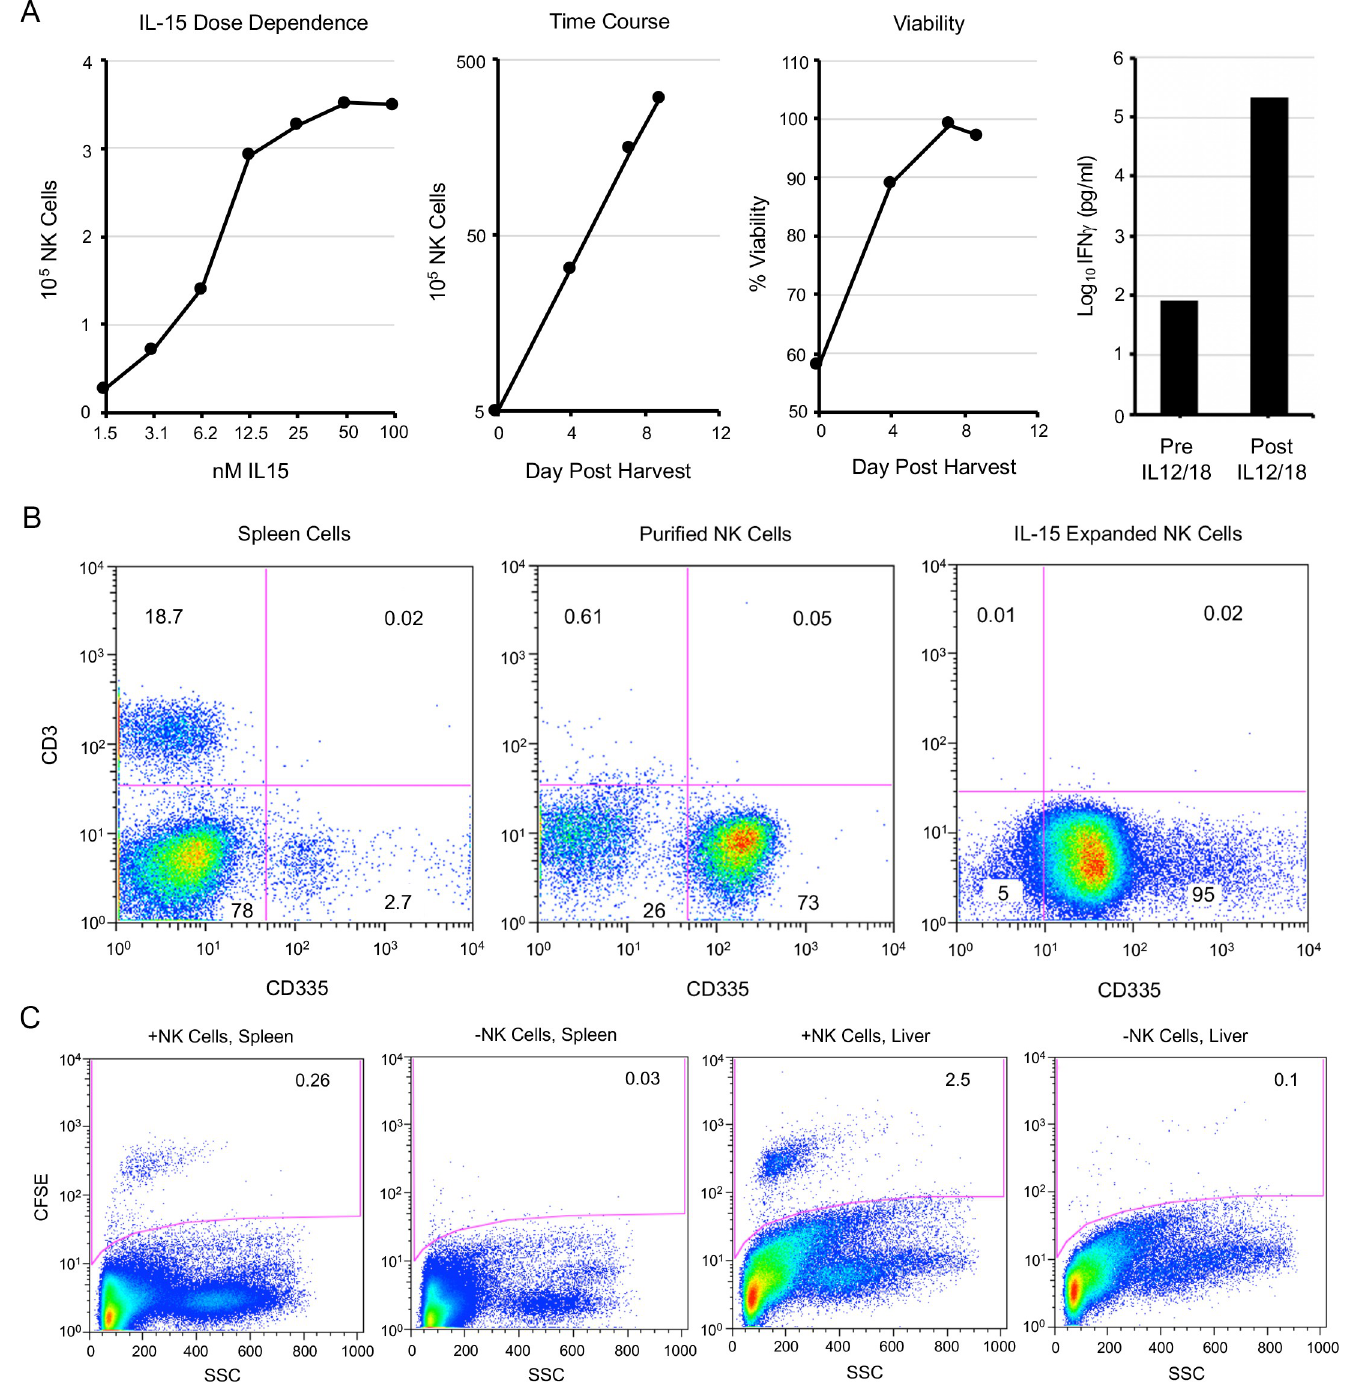
Fig 5. Purification and expansion of splenic NK cells. (A) Spleen cells from CAST mice were purified by negative selection. In left-most panel, 2-fold dilutions of IL- 15 were added to purified NK cells for 5 days at 37˚C and counted with a cellometer. Second panel from left shows expansion of NK cells incubated in 50 nM IL-15 over time. Third panel from left shows cell numbers and viability (trypan blue exclusion) determined with a cellometer in presence of 50 nM IL-15. Fourth panel from left shows the amounts of IFN- γ in the medium before and after incubation of expanded NK cells for 18 h with IL-12/IL-18. (B) Spleen cells before and after NK cell purification and following expansion with IL-15 were stained with anti-CD3 and anti-CD335 antibodies and analyzed by flow cytometry as described in the legend to Fig 1. (C) Purified and expanded NK cells were stained with CFSE and injected intravenously into CAST mice. After 12 h, spleen and liver cells from the mice injected with NK cells and control mice were analyzed by flow cytometry. Similar findings for CFSE were found in two independent experiments.